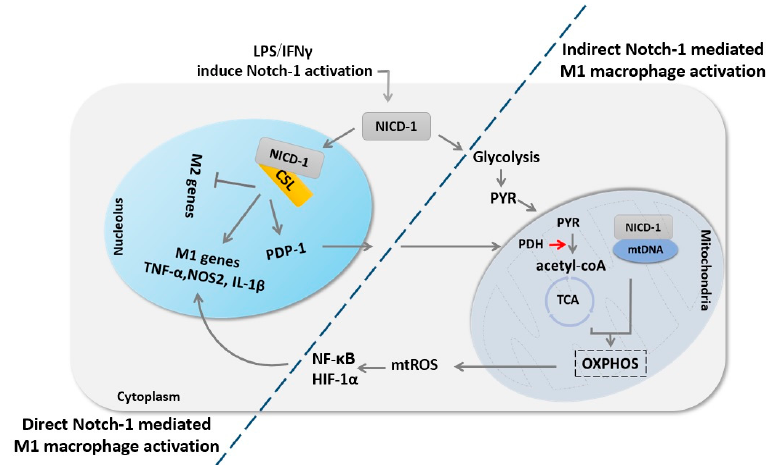
Figure 3. Notch-1 signaling regulates macrophage M1 fate through direct transcriptional regulation and indirect metabolic regulation. First, Notch-1 signaling activation results in the release of NICD-1, which translocates into the nucleus to induce M1 macrophage genes expression. Concurrently, Notch-1 activation enhances glycolysis combined with enhancing PDP-1 expression and subsequent PDH activity, which ultimately increases glucose flux to the tricarboxylic acid (TCA) cycle. NICD-1 also translocates to the mitochondria and induces mitochondria DNA (mtDNA) expression, glucose oxidation, mitochondrial oxidative phosphorylation (OXPHOS), and consequent mitochondrial reactive oxygen species (mtROS), which in turn induce NF- κ B and HIF-1 α activation, which results in augmentation of M1 macrophage genes